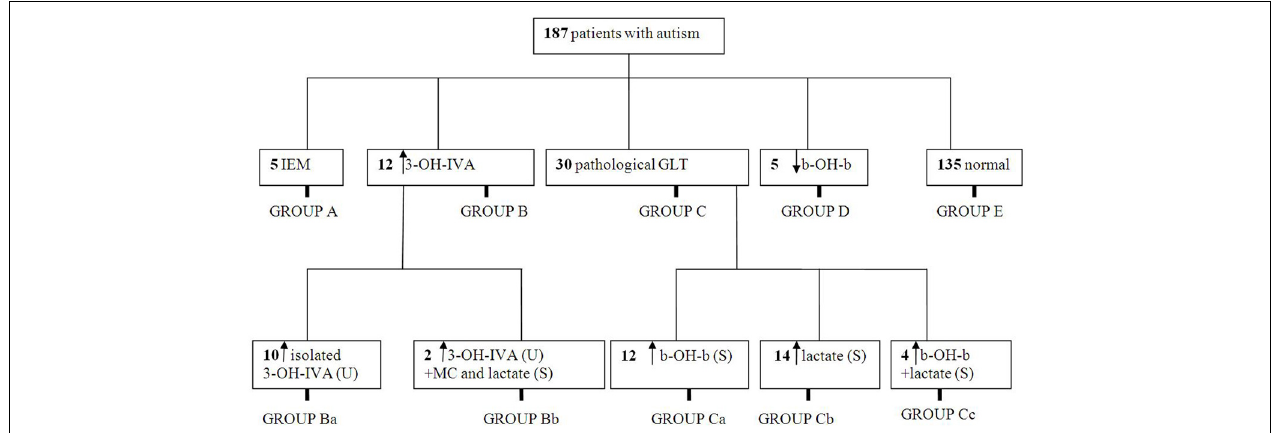
FIGURE 1 | Summary of metabolic abnormalities in the patients evaluated in this study. Abbreviations: IEM, inborn errors of metabolism ; 3-OH-IVA, 3 hydroxyisovaleric acid ; GLT, glucose loading test ; b-OH-b, β -hydroxybutyrate; MC, methylcitrate.